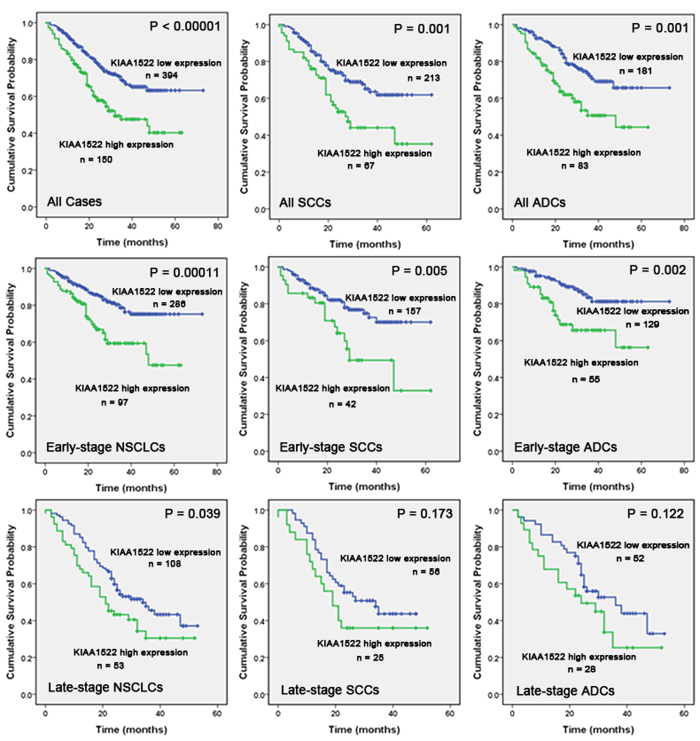
Relationship between expression of KIAA1522 and patient OS.Kaplan-Meier curves showing the association between expression of KIAA1522 and patients OS in all stages, in the stratified stages and in different histological tumor types in tissue samples (all of the P values are shown in the graph, by log-rank test).